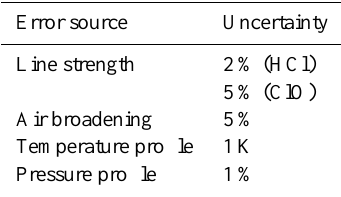
Table 3. Uncertainties in spectroscopic and atmospheric parame- ters used to determine the error budget for the HCl and ClO profile retrievals from the SIR channel of the TELIS instrument.